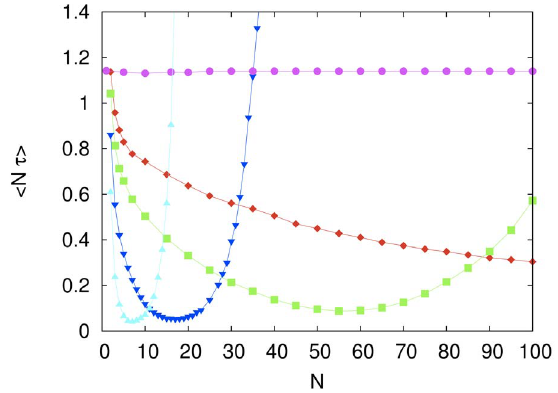
Figure 3. Deviation from the exponential distribution for a large imitation probability. Probability distribution P N t ð Þ of the rescaled computational cost for a search employing N ~ 20 fully connected agents with imitation probability p ~ 0 : 6 . The mean of this distribution is S N t T & 8 : 0 . The solid straight line is the fitting function a exp { bN t ð Þ with a ~ 0 : 03 and b ~ 1 = 15 in the regime of large cost. The influence network size is M ~ N { 1 . The distribution was generated using 10 5 independent searches.